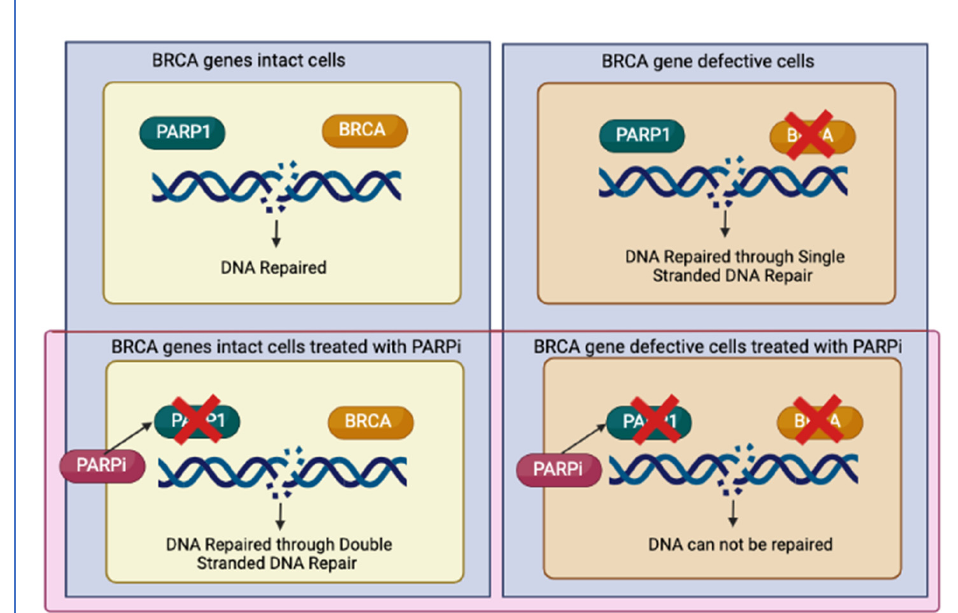
Figure 2. Synthetic lethality as the mechanism behind PARPi treated BRCA deficient cells leading to irreparable DNA damage.